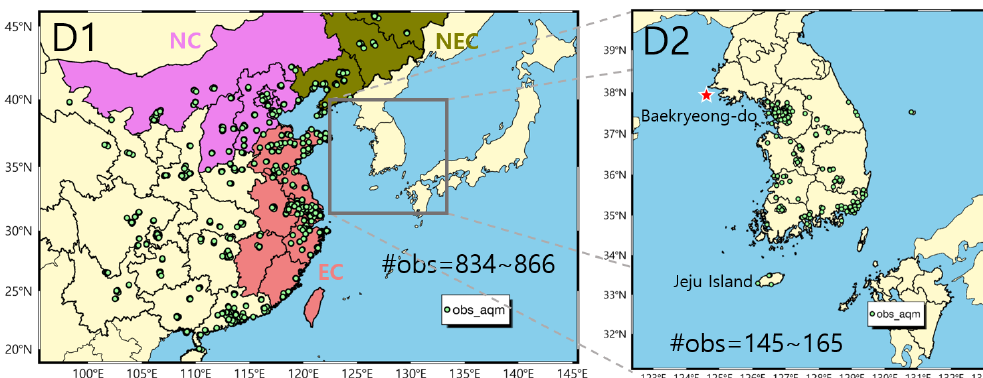
Figure 1. Simulation domains with nested modeling. D1 and D2 represent the mother and daughter domain, respectively. The locations of ground stations in China (D1) and South Korea (D2) are marked on the maps with green dots. In D1 (left), the northeastern China (NEC), northern China (NC), and eastern China (EC) regions that frequently influence air quality in South Korea are grouped with olive, violet, and coral colors, respectively. The red star symbol indicates Baekryeong-do observatory, where the evaluation of boundary inflow was made. Jeju Island in D2 (right) is an ideal location to see the flow-dependent correction by the EnKF DA. The total number of available stations used in EnKF data assimilation is also shown in both